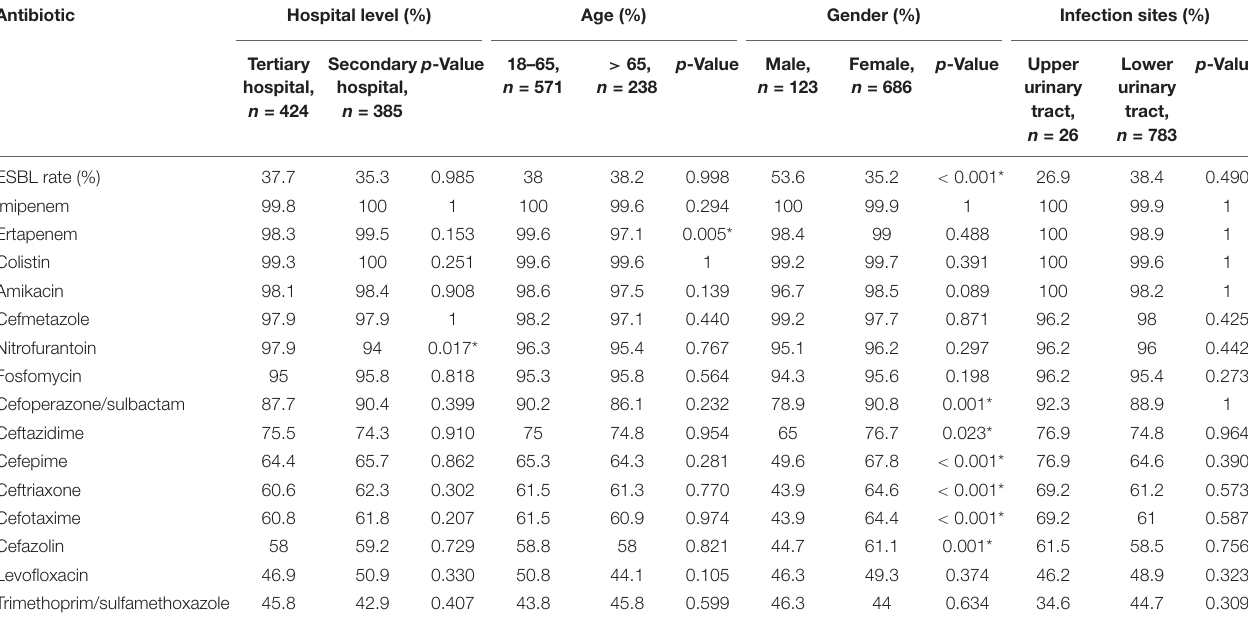
TABLE 3 | Comparison of the antimicrobial susceptibility rates of E. coli isolates in hospital level, demographic characteristics, and clinical features.